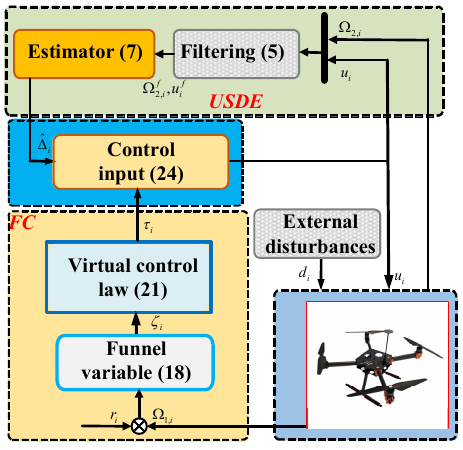
Figure 2. Flow chart of the proposed controller structure.